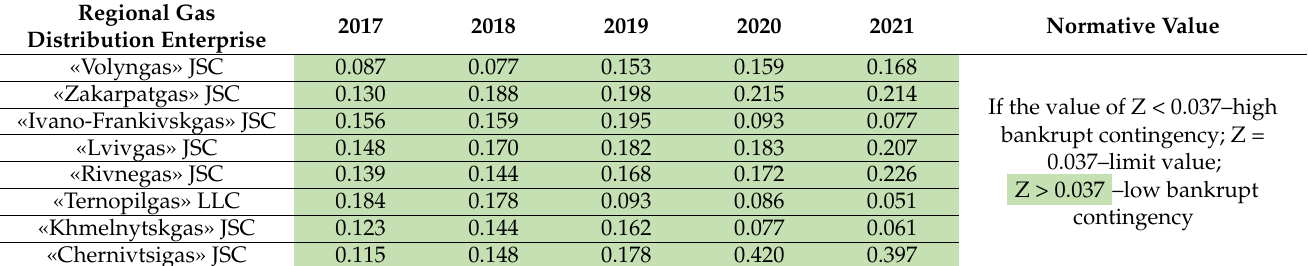
Table 6. Lis’s model approbation.